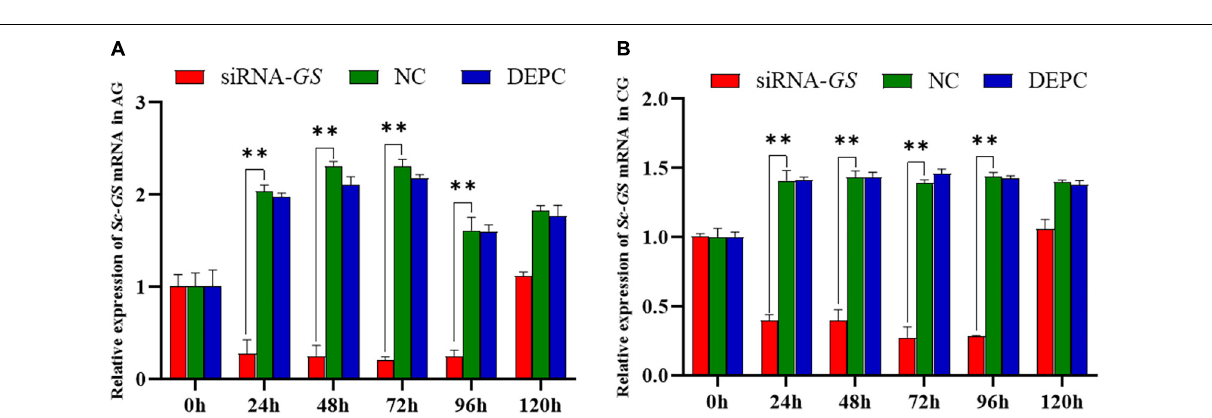
FIGURE 4 | Relative expression of Sc-GS genes in the hepatopancreas after RNA interference (RNAi) Time-course expression of Sc-GS genes in ammonia stress group (AG) after RNAi (A) . Time-course expression of Sc-GS genes in the control group (CG) after RNAi (B) . Vertical bars represent the mean ± SD ( n = 4). ∗∗ Denotes an extremely significant difference between Sc-GS small interfering RNA (siRNA- GS ) and negative control (NC) ( P <